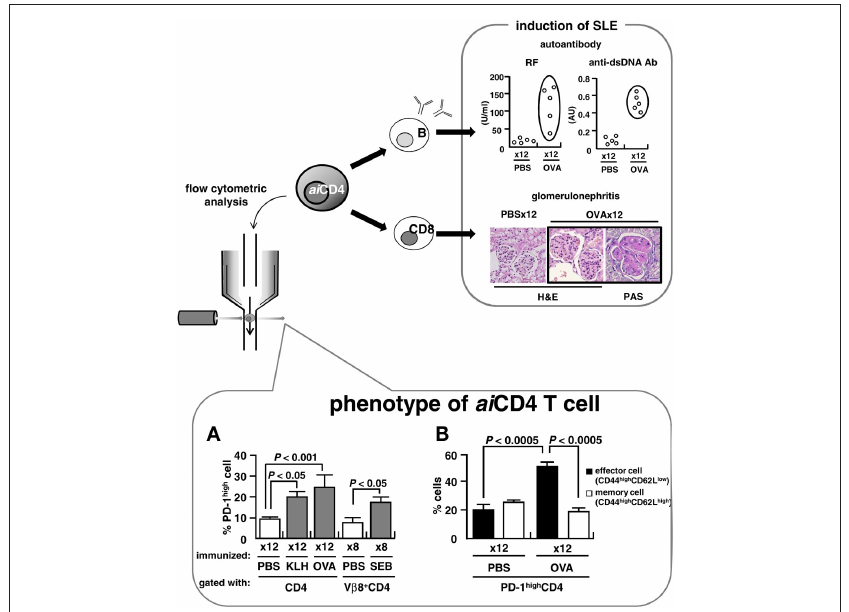
Figure 1 | Pathogenesis of SLe and ai CD4 T cell. BALB/c mice were repeatedly injected i.p. with 100 μg of keyhole limpet hemocyanin (KLH), 500 μg of OVA, 25 μg of staphylococcal enterotoxin B (SEB), or PBS every 5 days. Adjuvants were not used. (A,B) Flow cytometry analyses of CD4 T cells following 12 × repeated immunization with antigens (lower). Cells were stained on ice in the dark for 30 min with PerCP Cy5.5-conjugated anti-CD4 antibody (RM4-5), APC-conjugated anti-CD62L antibody (MEL-14), PE- conjugated anti-PD-1 antibody (J43) and anti-V β 8 TCR antibody (F23.1), or FITC-conjugated anti-CD44 antibody (IM7). Samples were analyzed using a BD PharMingen FACSCalibur instrument. Effector and memory functions of PD-1 high CD4 T cells were determined by expression of CD44 high CD62L low and CD44 high CD62L high markers,